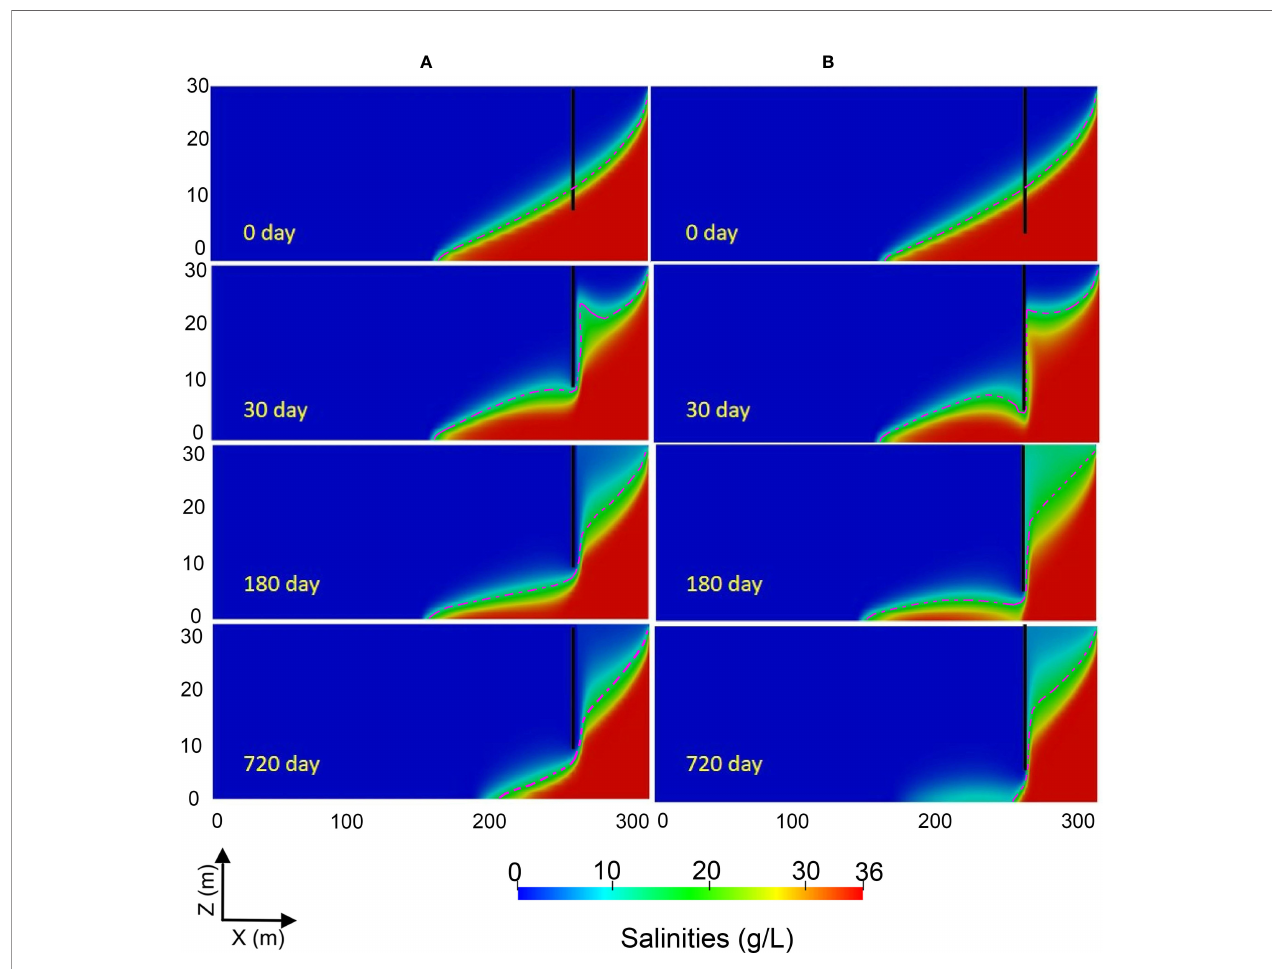
FIGURE 7 | Transient distributions of residual saltwater after the construction of a 20 m-depth (A) and a 25 m-depth (B) cut-off wall at 50 m from the seaward boundary at day 0, day 30, day 180 and day 720. The vertical black lines represent the cut-off walls, and the red dotted lines stand for the isolines of 50% saltwater